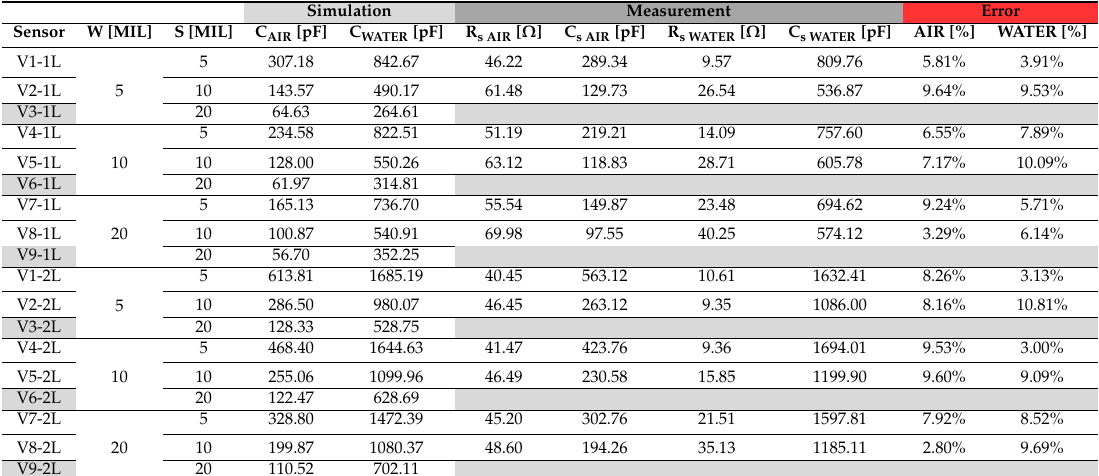
Table 3. Simulation and measurement results for the structures designed on a fixed thickness PCB. The environment is air ( (cid:101) r = 1) or distilled water ( (cid:101) r = 77). Variants with grayed-out rows were not manufactured.